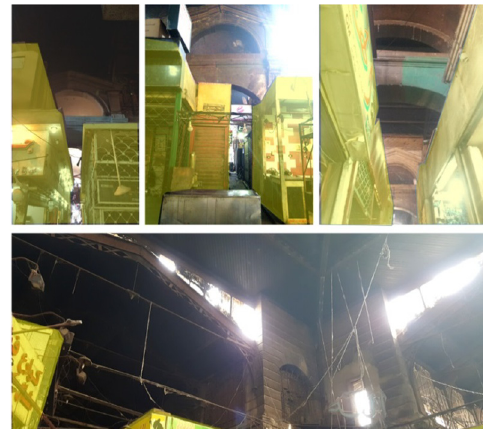
Figure 2. Attaba market from the outside – current